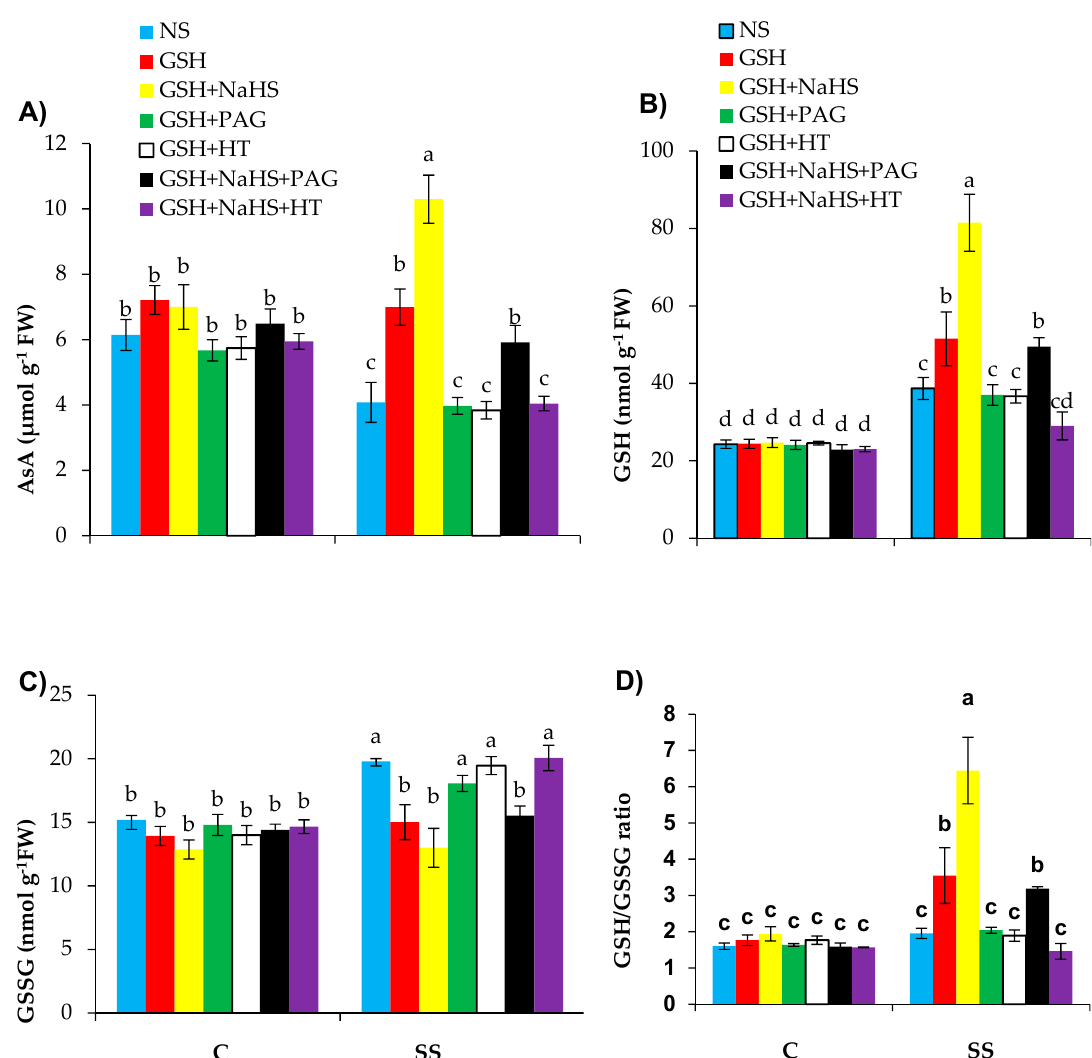
Figure 7. Ascorbate (AsA ( A )), glutathione (GSH ( B )), and glutathione disulfide (GSSG ( C )) on a fresh weight (FW) basis, and GSH / GSSG ratio ( D ) in pepper plants grown under control (C) and salinity stress (SS 100 mmol L − 1 NaCl), sprayed with glutathione (1.0 mmol L − 1 GSH) or sodium hydrosulfide (0.2 mmol L − 1 NaHS) alone or together, combined with a 0.1 mmol L − 1 scavenger of H 2 S, hypotaurine (0.1 mmol L − 1 HT), or inhibitor of l -DES, dl -propargylglycine (0.3 mmol L − 1 PAG). (Mean ± SE). Mean values carrying different letters within each parameter differ significantly ( p ≤ 0.001) based on Duncan’s multiple range test.